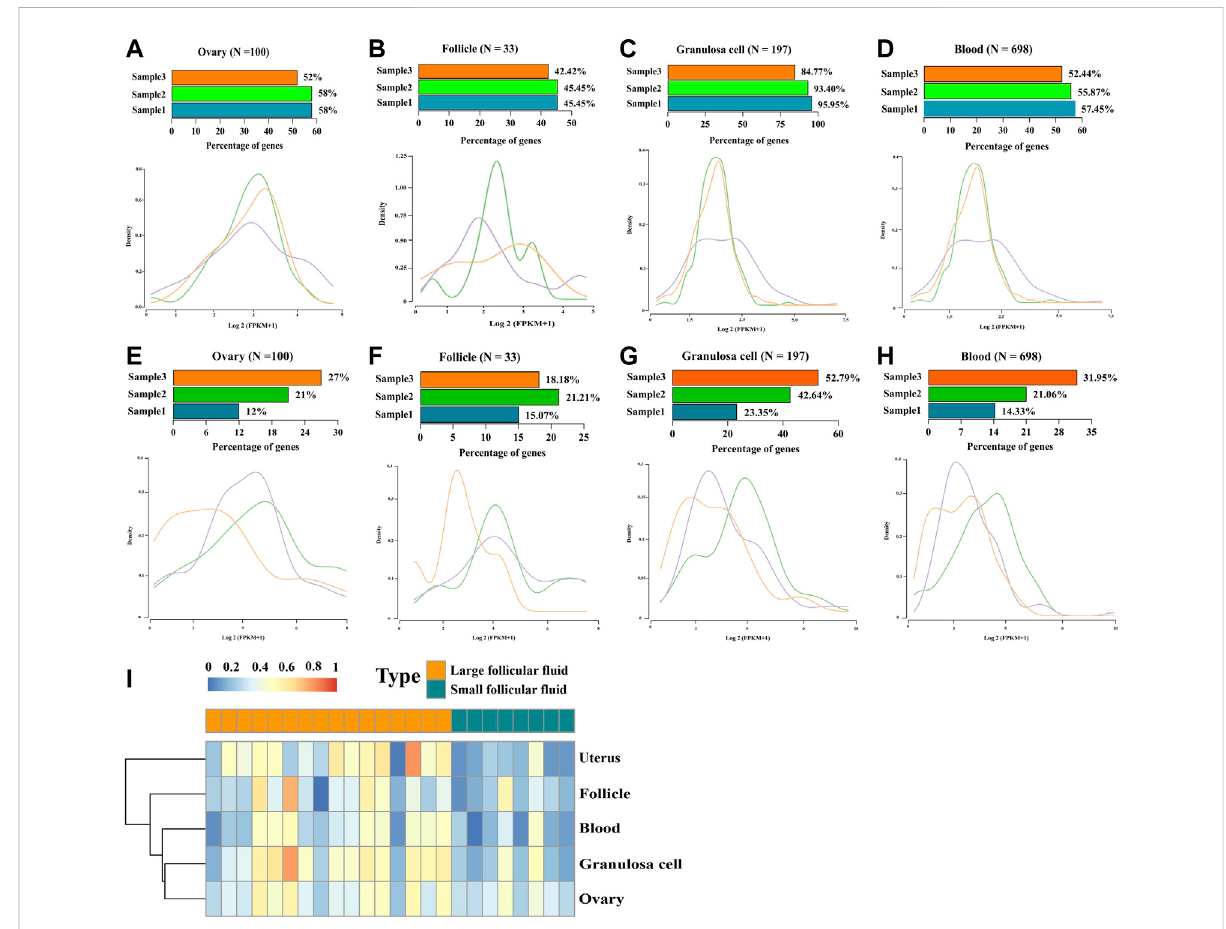
FIGURE 6 Origin of tissue-speci fi c genes in follicular fl uid. (A – D) Number and expression levels of the RNA derived from (A) ovary-, (B) follicle-, (C) granulosa cell-, and (D) blood-speci fi c genes in large follicular fl uid. (Upper) Percentage of RNA detected in each sample. N, the total number of genes speci fi cally expressed in this tissue. (Lower) Distribution of RNA expression from the corresponding tissue-speci fi c genes. (E – H) Number and expression levels of the RNA derived from (E) ovary-, (F) follicle-, (G) granulosa cell-, and (H) blood-speci fi c genes in small follicular fl uid. (Upper) percentage of RNA detected in each sample. N, the total number of genes speci fi cally expressed in this tissue. (Lower) distribution of RNA expression from the corresponding tissue-speci fi c genes. (I) Scores of four tissue-speci fi c genes per follicular fl uid sample were analyzed by using the single-sample Gene Set Enrichment Analysis (ssGSEA) scores (red shows a high score, and blue shows a low